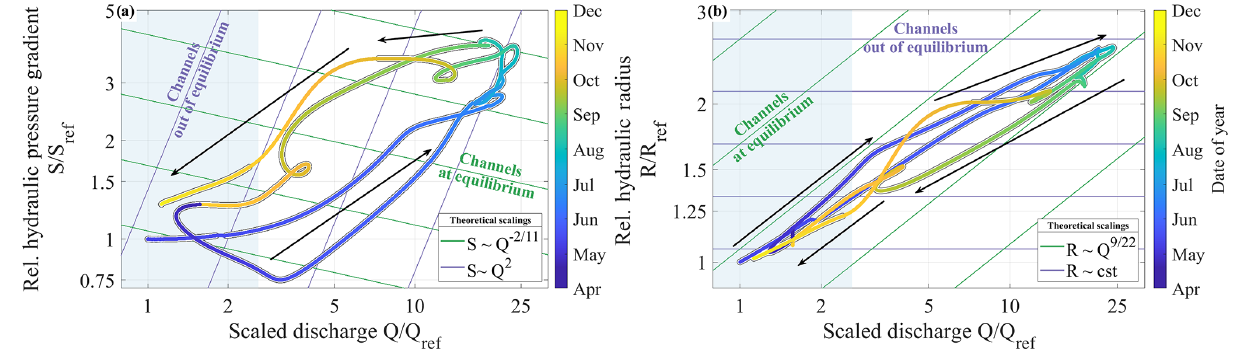
Figure 10. (a) Relative hydraulic pressure gradient S and (b) hydraulic radius R as inverted from seismic observations and as shown as a S ref R ref function of measured relative water discharge Q . Time series of R and S are calculated from 5d low-pass-filtered time series of Q and P w Q ref and are then 30d low-pass-filtered (same as in Fig. 8). Time series of Q is 30d low-pass-filtered. Reference values for all three variables are taken as the first day of the 2017 melt season (10 May 2017). We compare our data to the predictions of Röthlisberger (1972) for subglacial channels evolving at equilibrium with Q (green lines; S ∝ Q − 2 / 11 and R ∝ Q 9 / 22 ) and for subglacial channels evolving through hydraulic = 0). Arrows show the direction of time. Blue shaded areas represent the period pressure gradient changes only (blue lines; S ∝ Q 2 and δR δQ when Q is lower than 1m 3 s − 1 . Line sections without the black edges show interpolated values of R and S using a cubic spline interpolation, as in Fig.